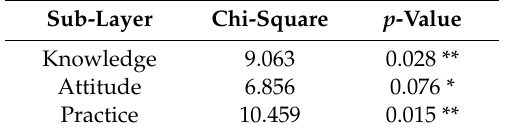
Table A7. Results of the chi-square test for the FSWs in the KAP